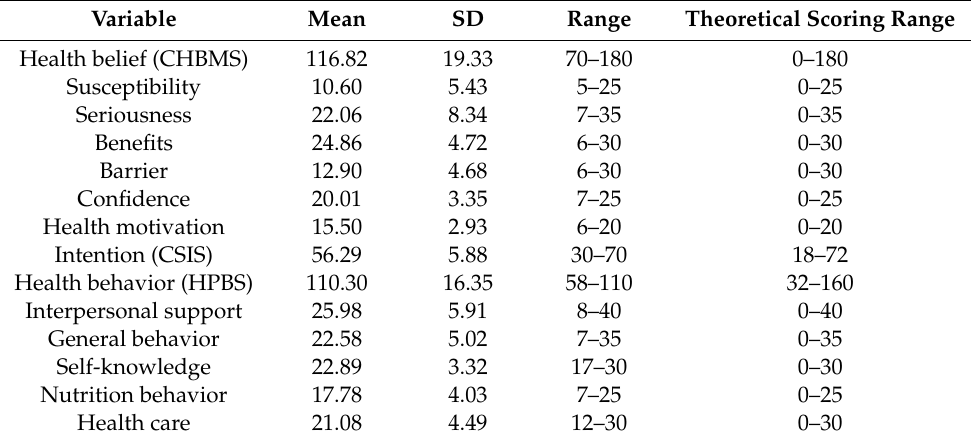
Table 2. Scores for health belief, intention, and health behavior (N =